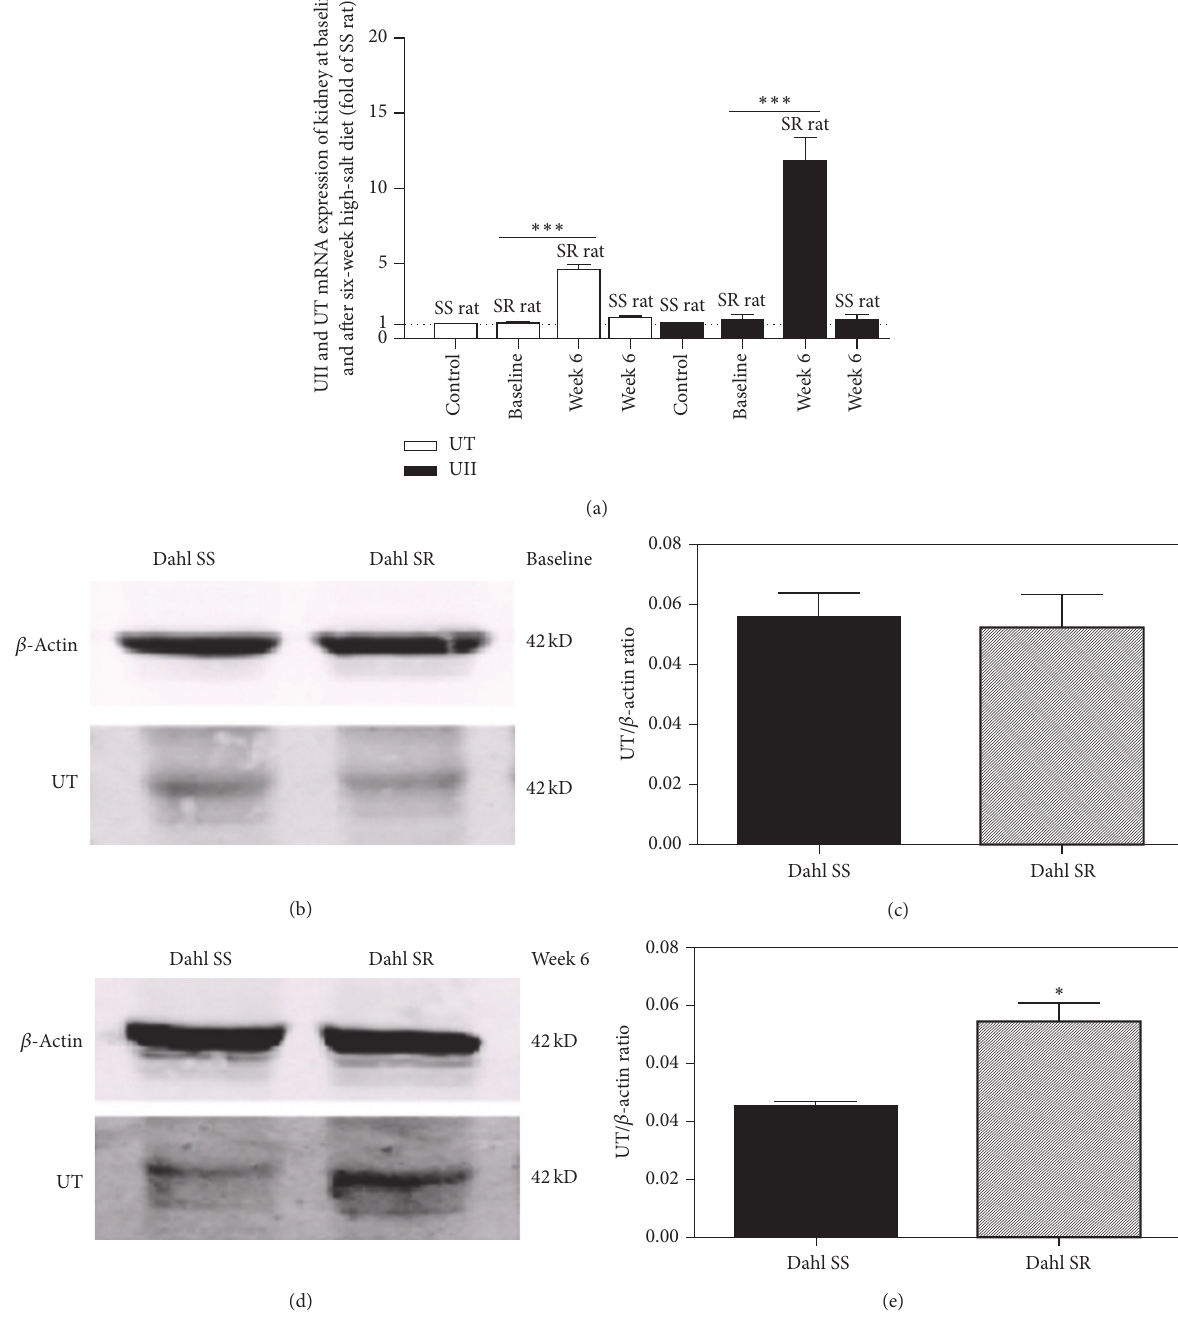
Figure 4: Figure 4 showed comparison of mRNA expression (a) and protein of UII and UT in kidney (b, c, d, and e) by real-time PCR and Western blot between SR group and SS group at baseline and after six weeks of high-salt diet. ∗∗∗ 𝑃 < 0.001 versus SS group (versus SS rats, week 6, in (a)). ∗ indicates 𝑃 < 0.05 versus SS